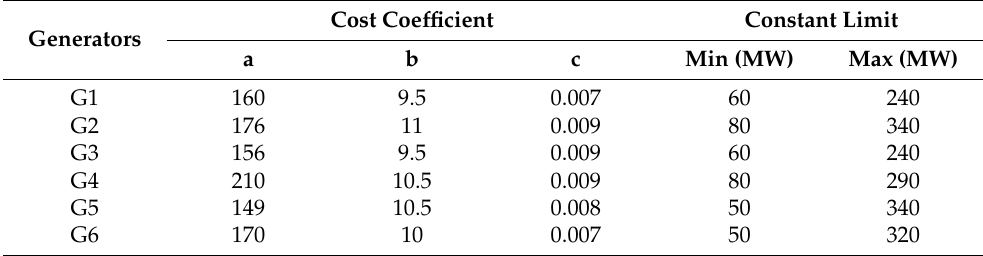
Table 1. Generation constraints and cost